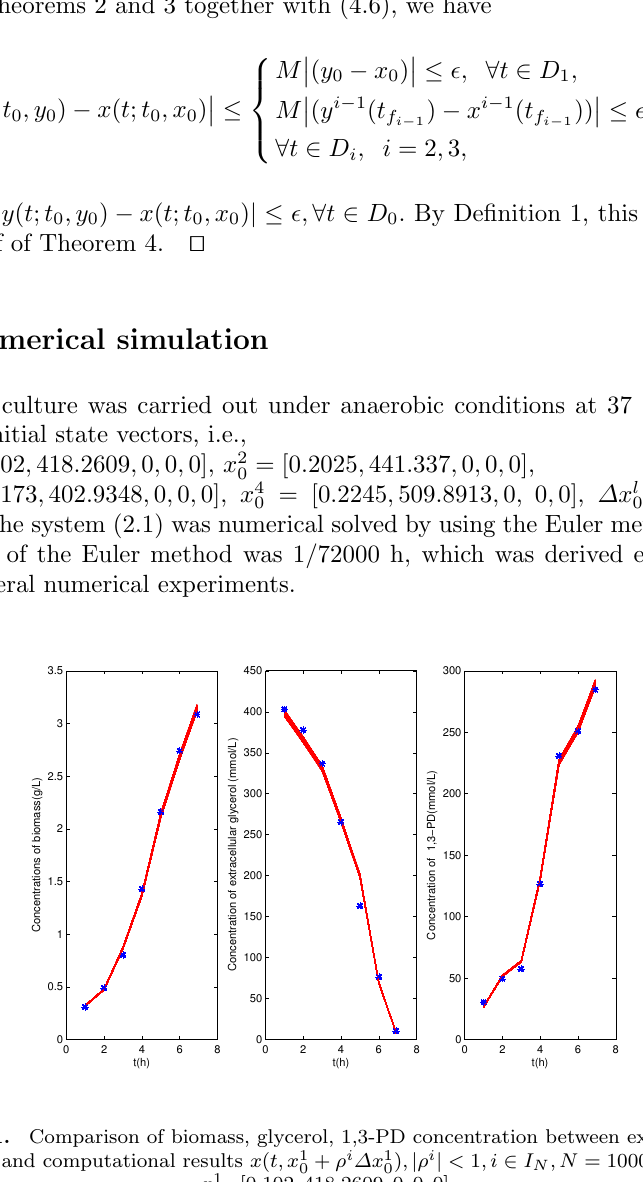
+ ρ i ∆x 1 ) , | ρ i | < 1 ,i ∈ I N ,N = 1000 , with 0 0 x 1 =[0 . 102 , 418 . 2609 , 0 , 0 , 0